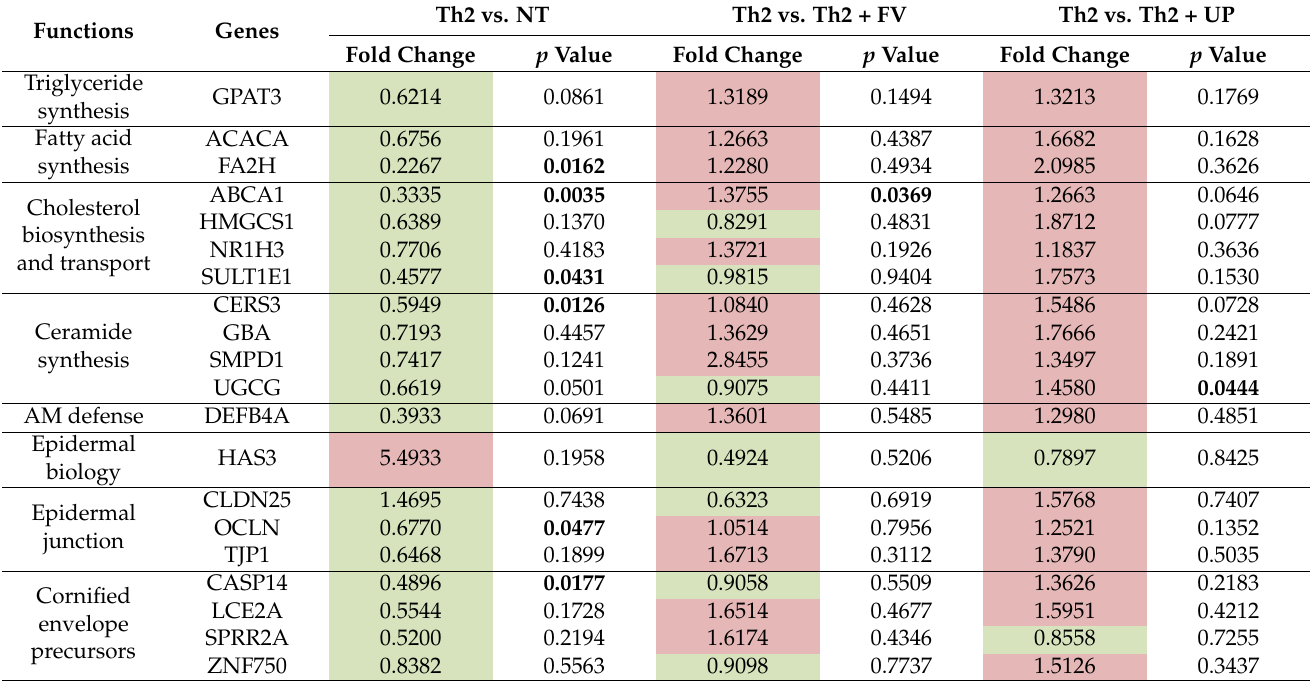
Table 3. The list for genes involved in complementary regulations about lipid homeostasis and potential regulations on barrier recovery. The increases and decreases are in green and red, respectively, and the significant p -values in